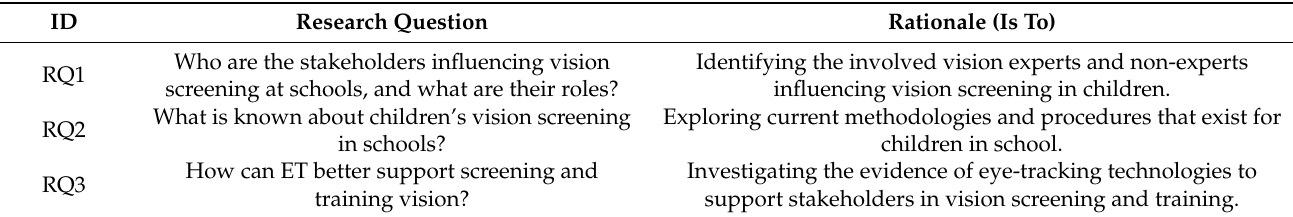
Table 1. Questions defined for the rapid